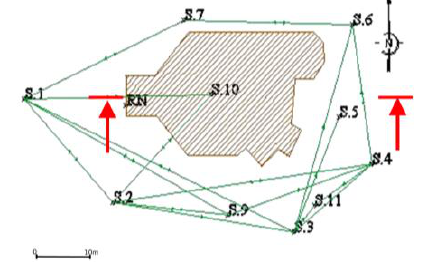
Figure 2. Topographical network (in green) and axis of the sectional view to create (in red)